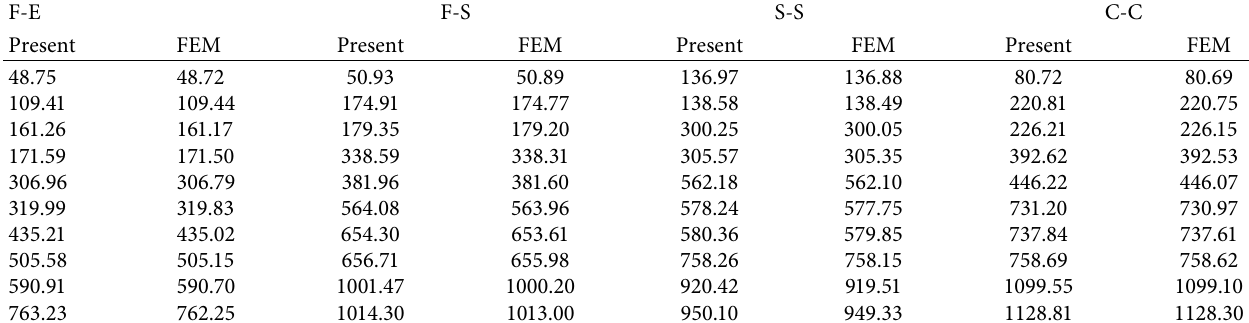
Table 4: Comparison of the first 10 natural frequencies under different boundary conditions (unit Hz). F-E F-S S-S C-C Present FEM Present FEM 48.75